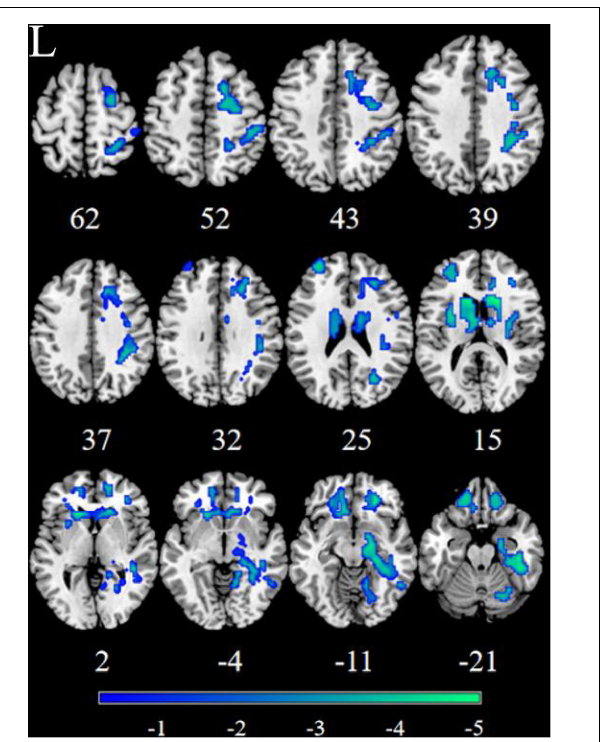
FIGURE 2 | Significant decreased resting-state functional connectivity (RSFC) of the left nucleus accumbens (NAc) in patients, compared with HC. The blue regions in the brain slices present the location of difference (GRF